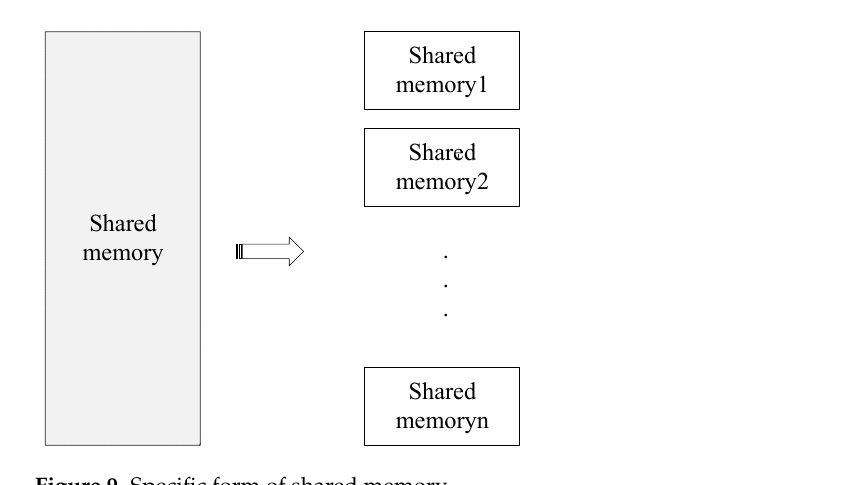
Figure 9. Specific form of shared memory.